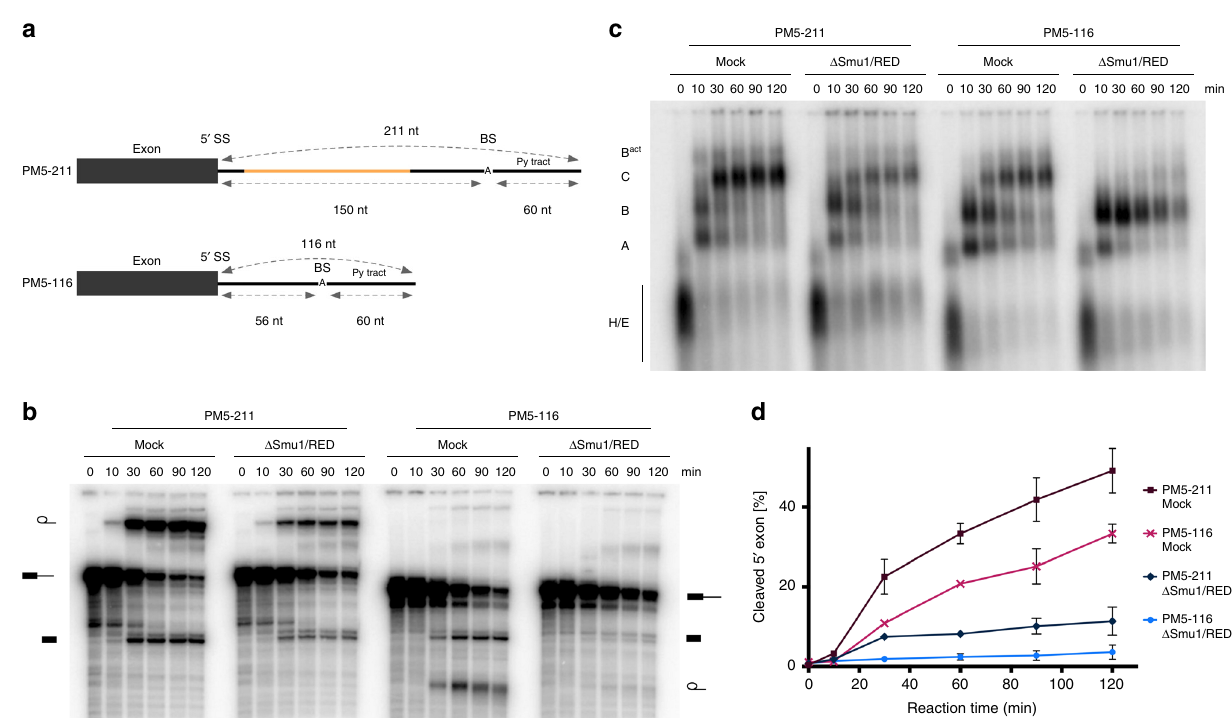
Fig. 3 The distance between the 5 ′ SS and BS determines whether splicing is Smu1/RED-dependent. a Schematic of PM5-211 and PM5-116 pre-mRNAs. The variable region is illustrated in orange. The lack of a 3 ′ exon stalls splicing after the fi rst catalytic step (i.e. at the C complex). b , c Kinetics of in vitro splicing ( b ) and spliceosome assembly ( c ) in the presence or absence of Smu1/RED. 32 P-labelled PM5-211 and PM5-116 were incubated under splicing conditions in the presence of mock-depleted or Smu1/RED-immunodepleted HeLa nuclear extract for 0 – 120 min. The pre-mRNA and splicing intermediates, as well as spliceosomal complex formation were analysed as in Fig. 2. d Quanti fi cation of the percent of spliced mRNA generated with the PM5-211 and PM5-116 pre- mRNAs in Mock- or Δ Smu1/RED-depleted extract. Error bars represent the standard deviation obtained from two independent experiments. Source data are provided as a Source Data fi